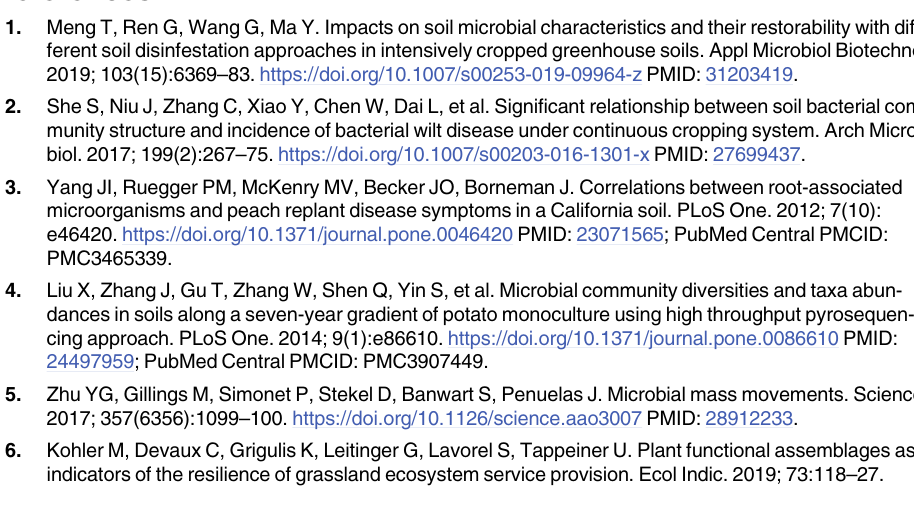
group. (A-E) The OTU 3 : The OW disinfestation 3 : The OW disinfestation 3